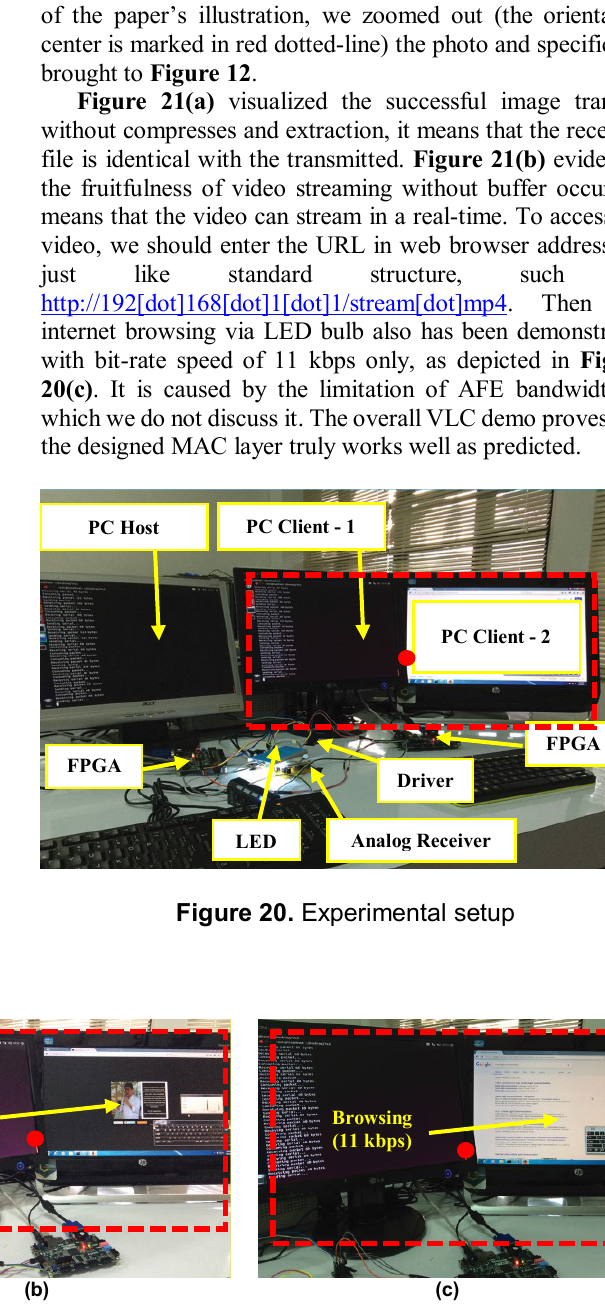
Figure 21. Successfully demonstration of: (a) an image transfer with 512 pixels@500 kb, taken from [23] ; (b) a real-time video streaming with resolution of 360p or 640 x 360, taken from [24] ; internet access